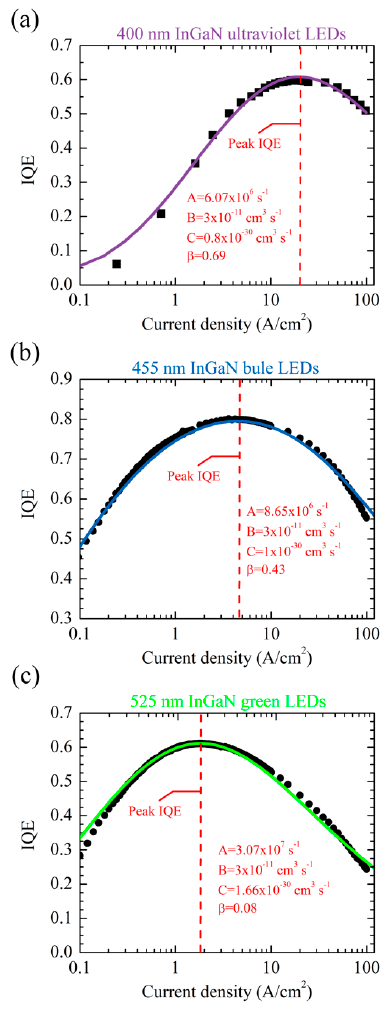
Figure 1. Fitting results to experimental internal quantum efficiency (IQE) versus current for InGaN ( a ) near-ultraviolet (NUV), ( b ) blue, and ( c ) green